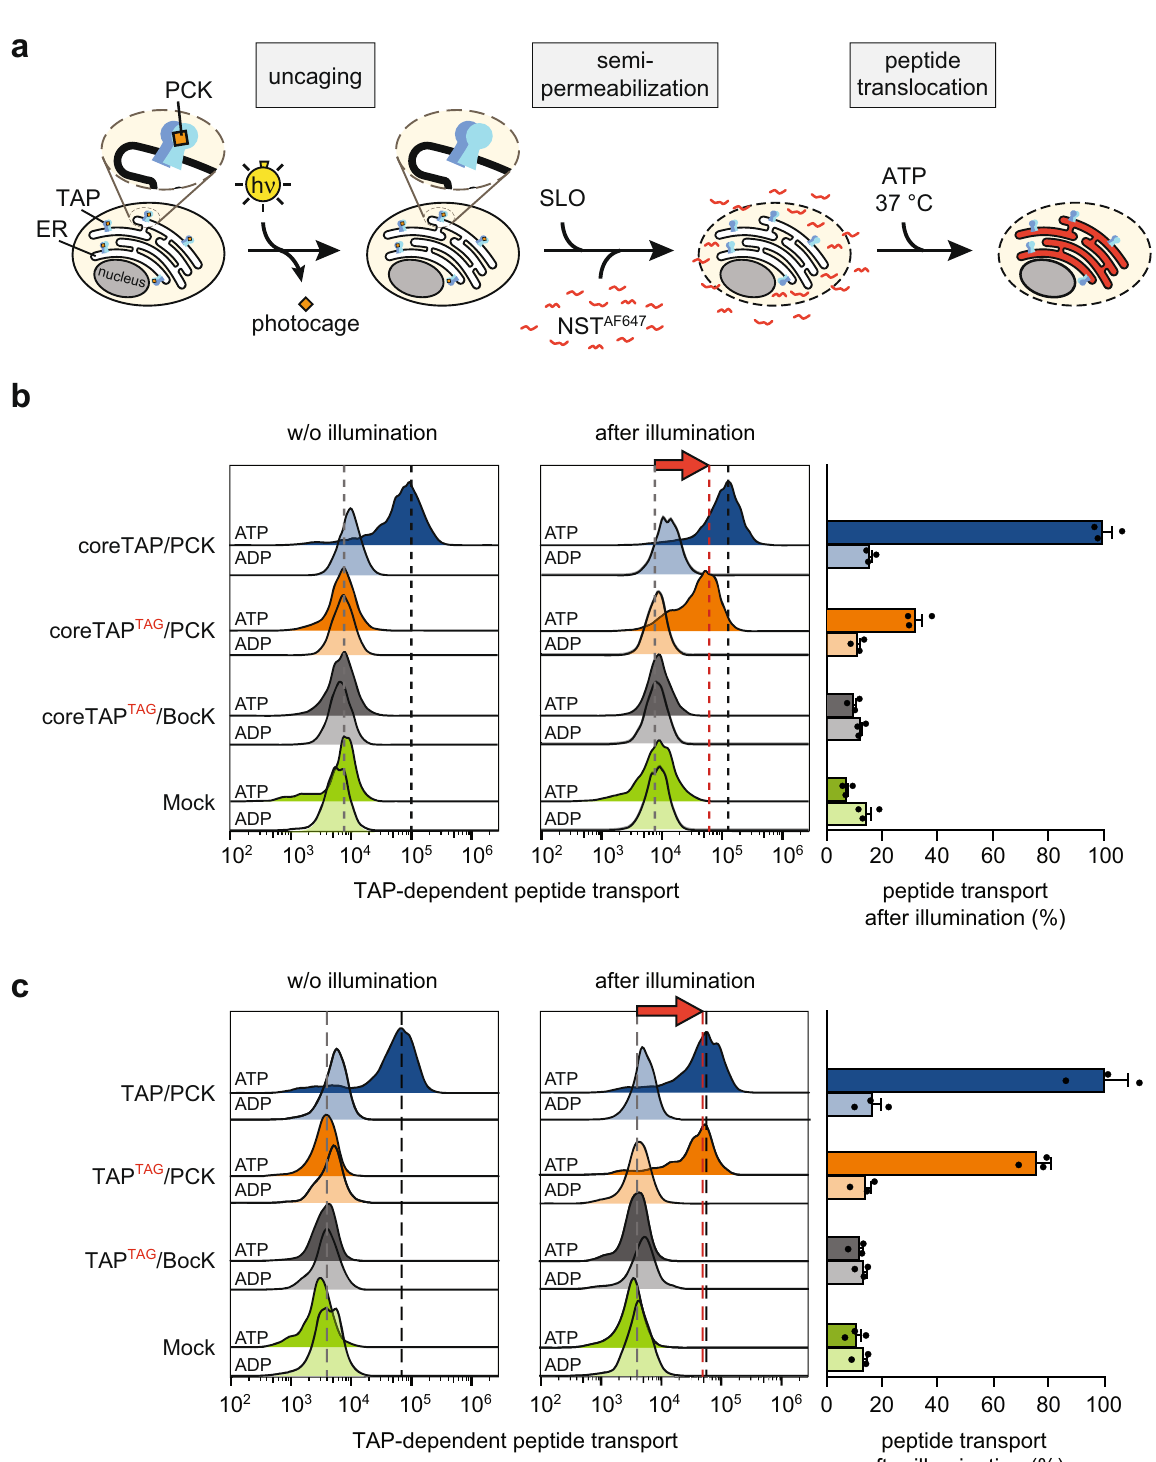
Fig. 4 Antigen translocation triggered by light. a Schematic representation of TAP-dependent peptide translocation. TAP2-de fi cient STF1-169 cells expressing photo-conditional TAP were illuminated and semi-permeabilized with streptolysin O (SLO). Peptide translocation was performed at 37 °C in the presence of fl uorescently labeled NST AF647 peptide and ADP or ATP. b Peptide translocation of TAP2-de fi cient STF1-169 cells expressing coreTAP or c TAP variants without and with illumination was monitored by fl ow cytometry. mVenus expression served as mock control. The dotted lines represent the mode FI of the transported peptide of the corresponding amber-free counterpart (black) and the photo-conditional variants before (gray) and after illumination (red). Peptide transport after illumination was determined by normalizing the mean FI (± SEM, n = 3, biologically independent samples) of transported peptide to the corresponding amber-free variant in presence of ATP. FI fl uorescence